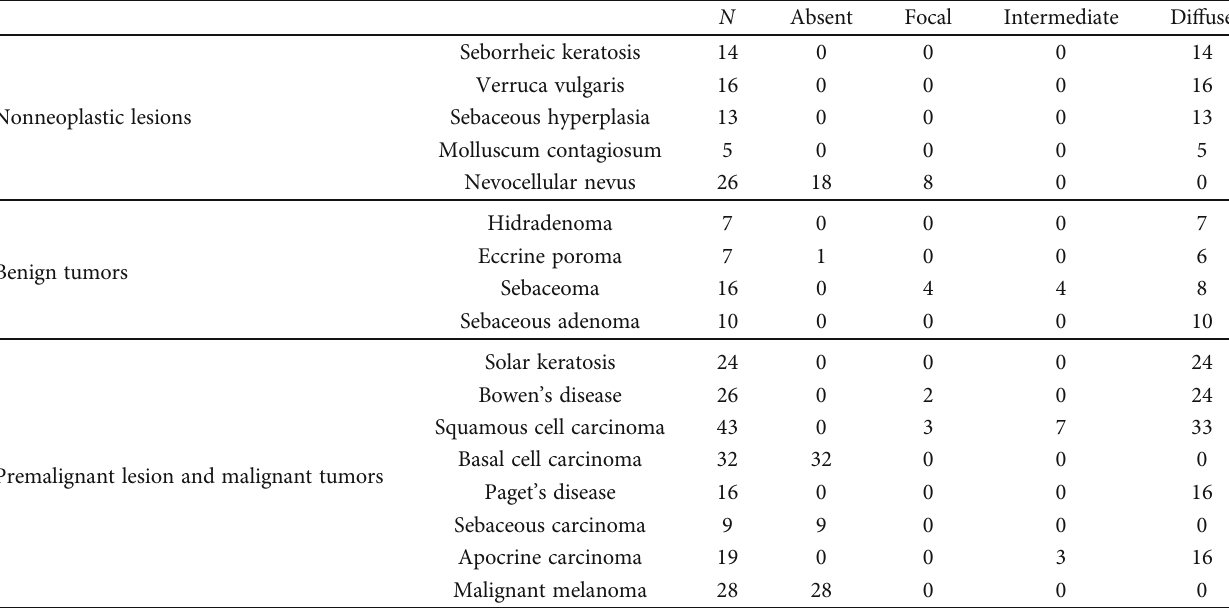
Table 1: Summary of immunohistochemistry for AQP3 in skin lesions.